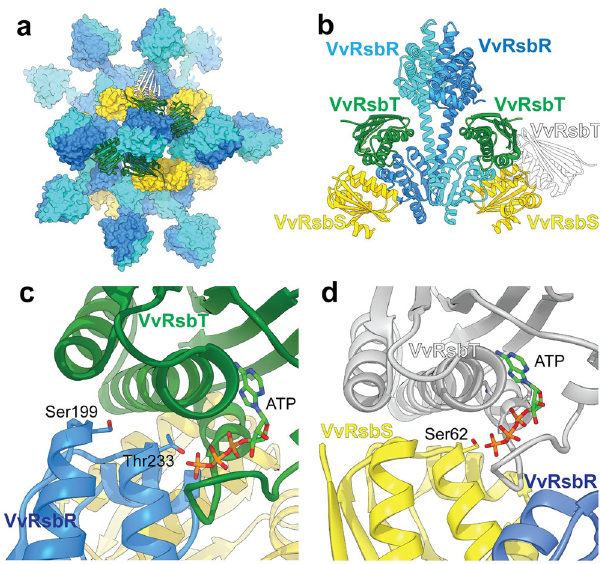
Fig. 7 Interaction of Vv RsbT with phosphorylation sites in Vv RsbR and Vv RsbS. A homology model of Vv RsbT was generated and docked to Vv RsbR and Vv RsbRS. a A space- fi lling model of the Vv RsbRS stressosome complex is shown with Vv RsbR 2 and Vv RsbS 2 dimers colored in blue and yellow, respectively. Vv RsbT (ribbon model) was docked to the Vv RsbR 2 ( Vv RsbT in green) or Vv RsbS 2 ( Vv RsbT in white). b Side view of the Vv RsbR Vv RsbS monomers with docked Vv RsbT colored as 2 dimer and two in ( a ). Close-up views show that binding of Vv RsbT to neighboring Vv RsbR or Vv RsbS is possible without steric clashes. The ATP binding site in Vv RsbT docked to Vv RsbR ( c ) and Vv RsbS ( d ) in the stressosome assembly. The respective phosphorylation sites are indicated (carbon atoms in blue or yellow respectively, oxygen atoms in red, and nitrogen atoms in dark